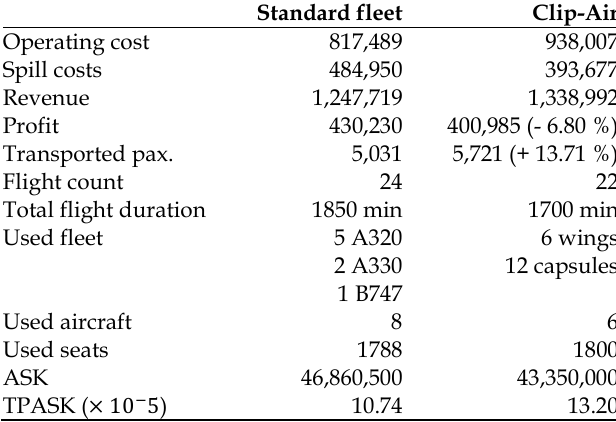
Table 7. Results for the hub-and-spoke network